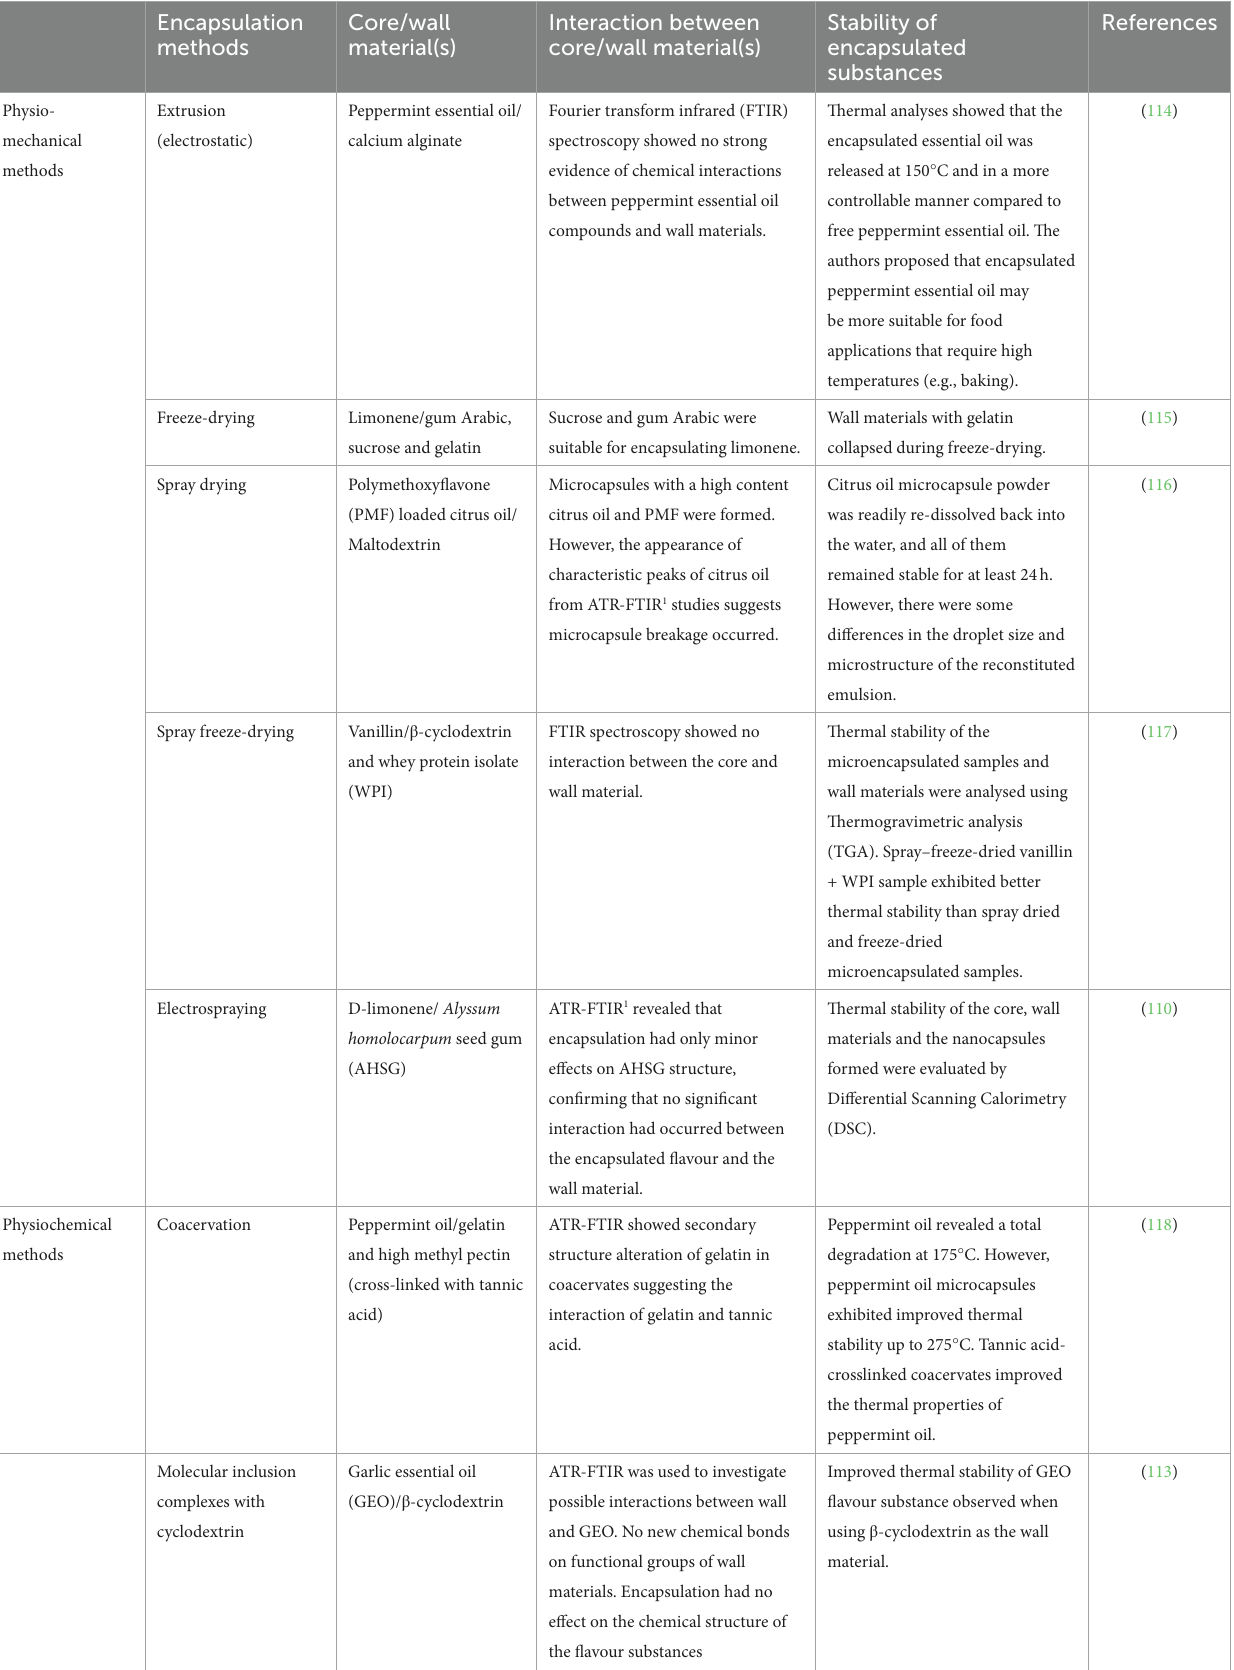
TABLE 2 Physio-mechanical and physiochemical encapsulation methods and representative studies that highlight the interactions between core and wall material and the stability of encapsulated